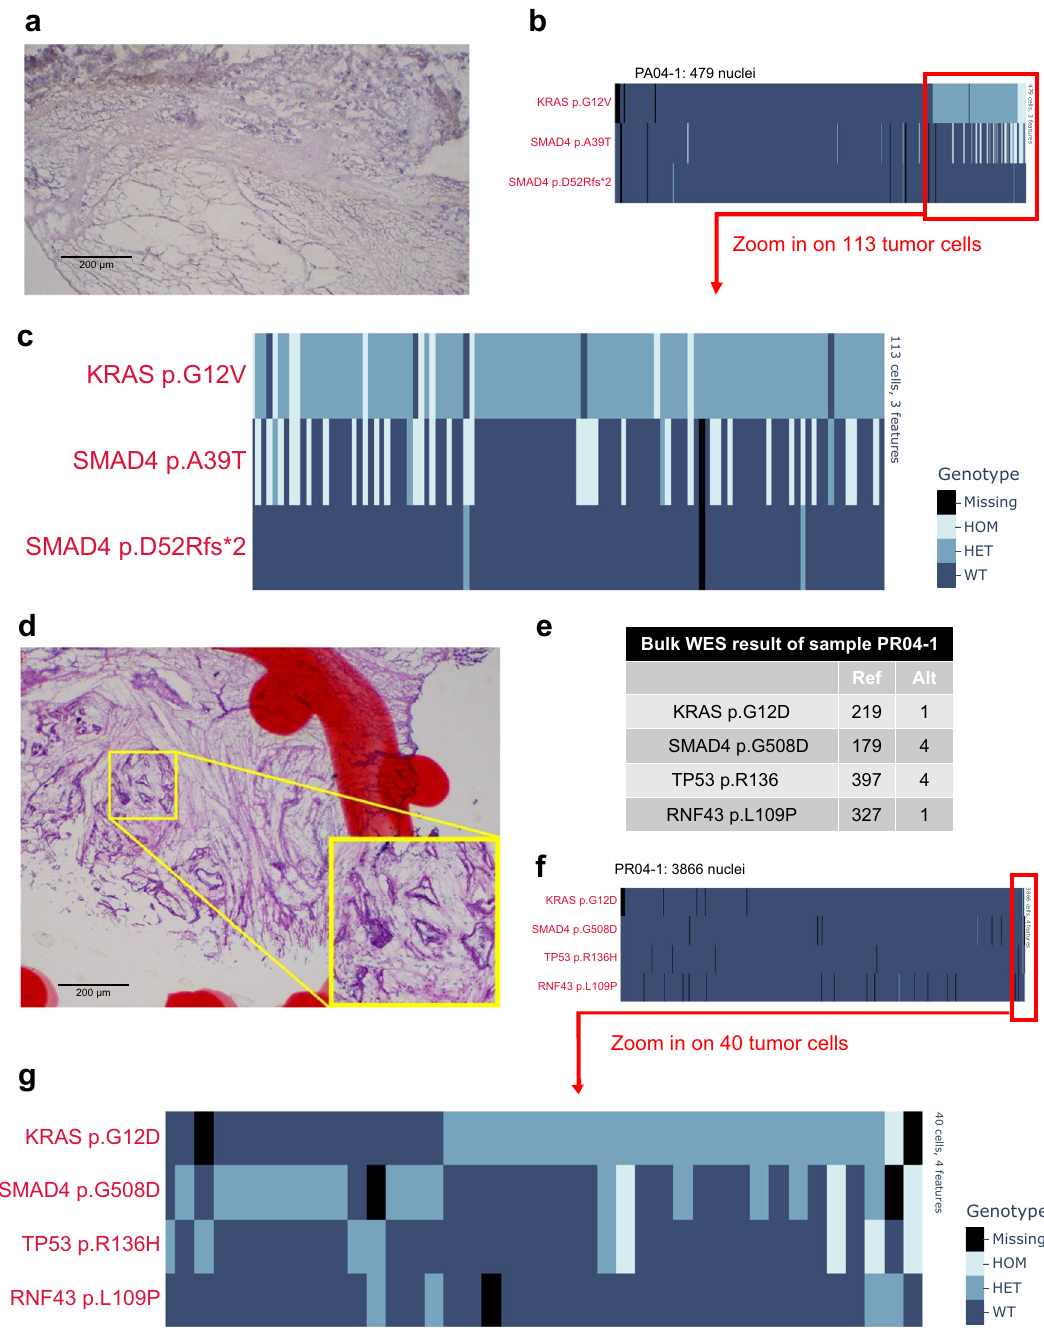
Fig. 3 | SnDNA-seq ’ s performance in limiting settings. a Representative hema- toxylin and eosin (H&E) stained histology image of sample PA04-1, a sample of particularlylowcellularityduetohighfatcontent.Atleast3representativepictures were taken per sample and yielded similar results. b Single-cell genotype (HOM: homozygous mutation; HET: heterozygous mutation; WT: wildtype) heatmap of sample PA04-1. A total of 479 captured single nuclei were sorted based on KRAS VAF in ascending order from left to right. c Single-cell genotype (HOM: homo- zygous mutation; HET heterozygous mutation, WT wildtype) heatmap of sample PA04-1, zoomed in on 113 putative tumor cells, de fi ned by the presence of